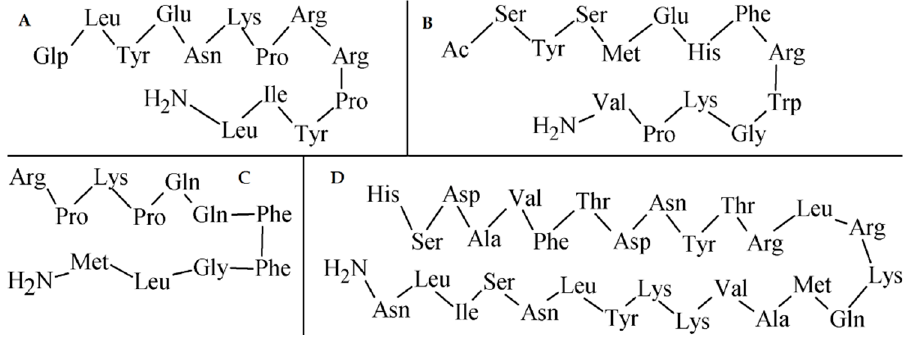
Figure 17. AA sequences of other important peptides for tumor imaging. ( A ) neurotensin; ( B ) α -MSH; ( C ) substance P; ( D ) VIP.